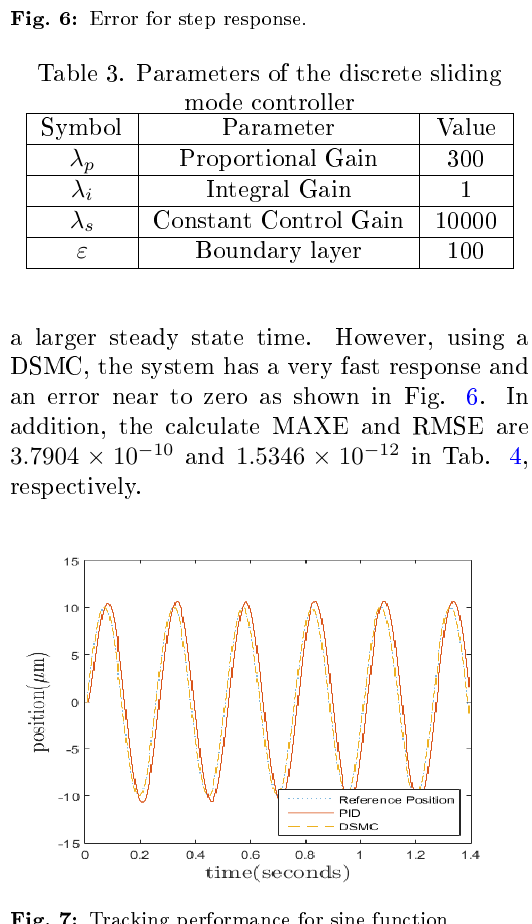
Fig. 7: Tracking performance for sine